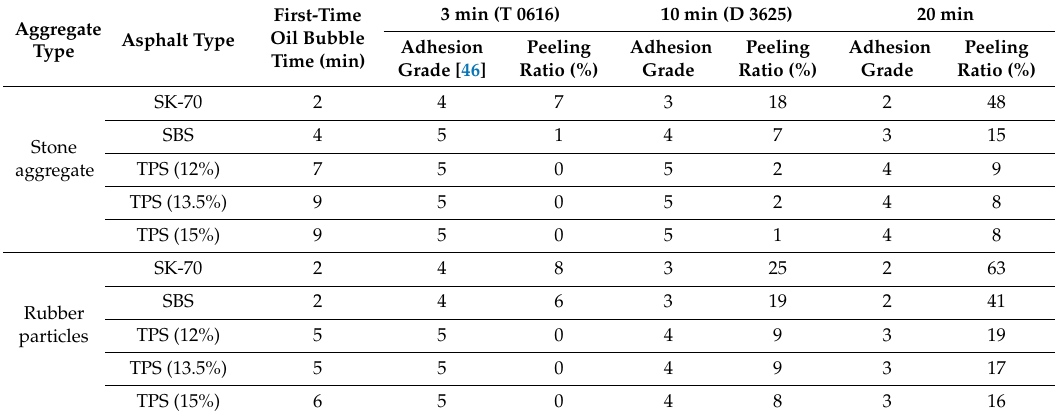
Table 4. Results of water-boiling test.